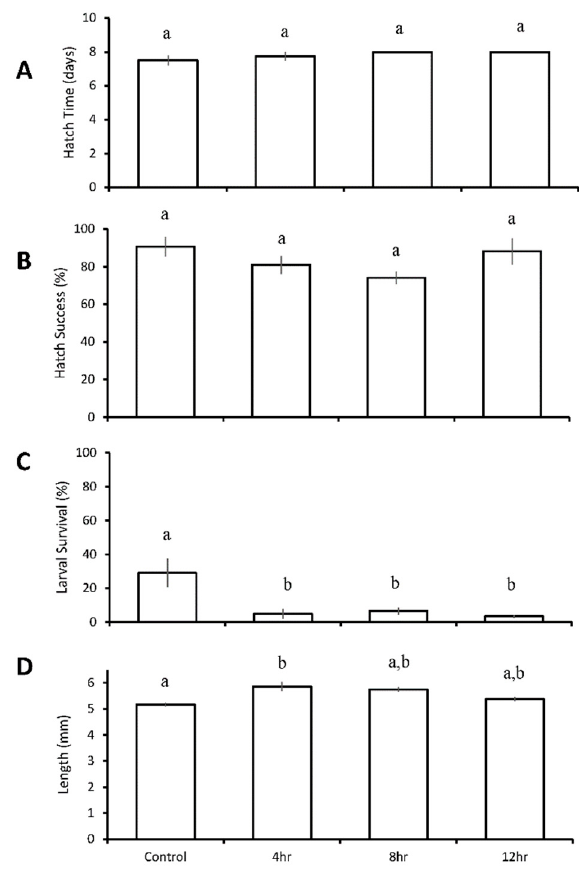
Figure 7. Hatch time ( A ), hatch success ( B ), survival ( C ), and length ( D ) of Menidia menidia larvae in the four treatment diurnal duration acidification and hypoxia experiment (Table 8 and Tables S25–S28) Bars represent the mean (n = 4) for each treatment. Error bars represent standard error of the mean (n = 4). Letters on bars represent significant differences among groups as determined by Tukey Honest Significance Difference tests.